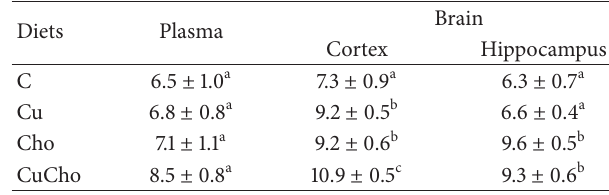
CuCho 2.4 ± 0.1 1.7 ± 0.1 Results were obtained as described in Section 2.11.1. They were expressed as the mean of 10 independent determinations ± SD. There are no statistical differences ascribed to the experimental diet.